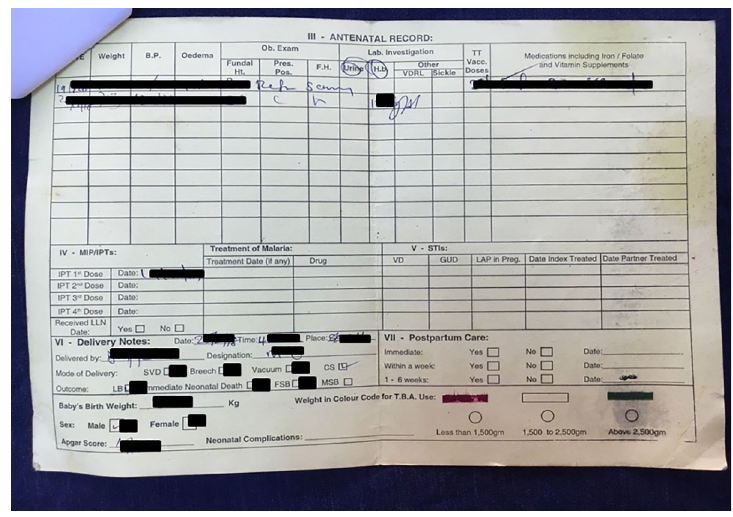
Fig 2. The inside of the government issued women-held ‘yellow Maternity Card’. Generally this side of the card contains information relevant post-discharge.